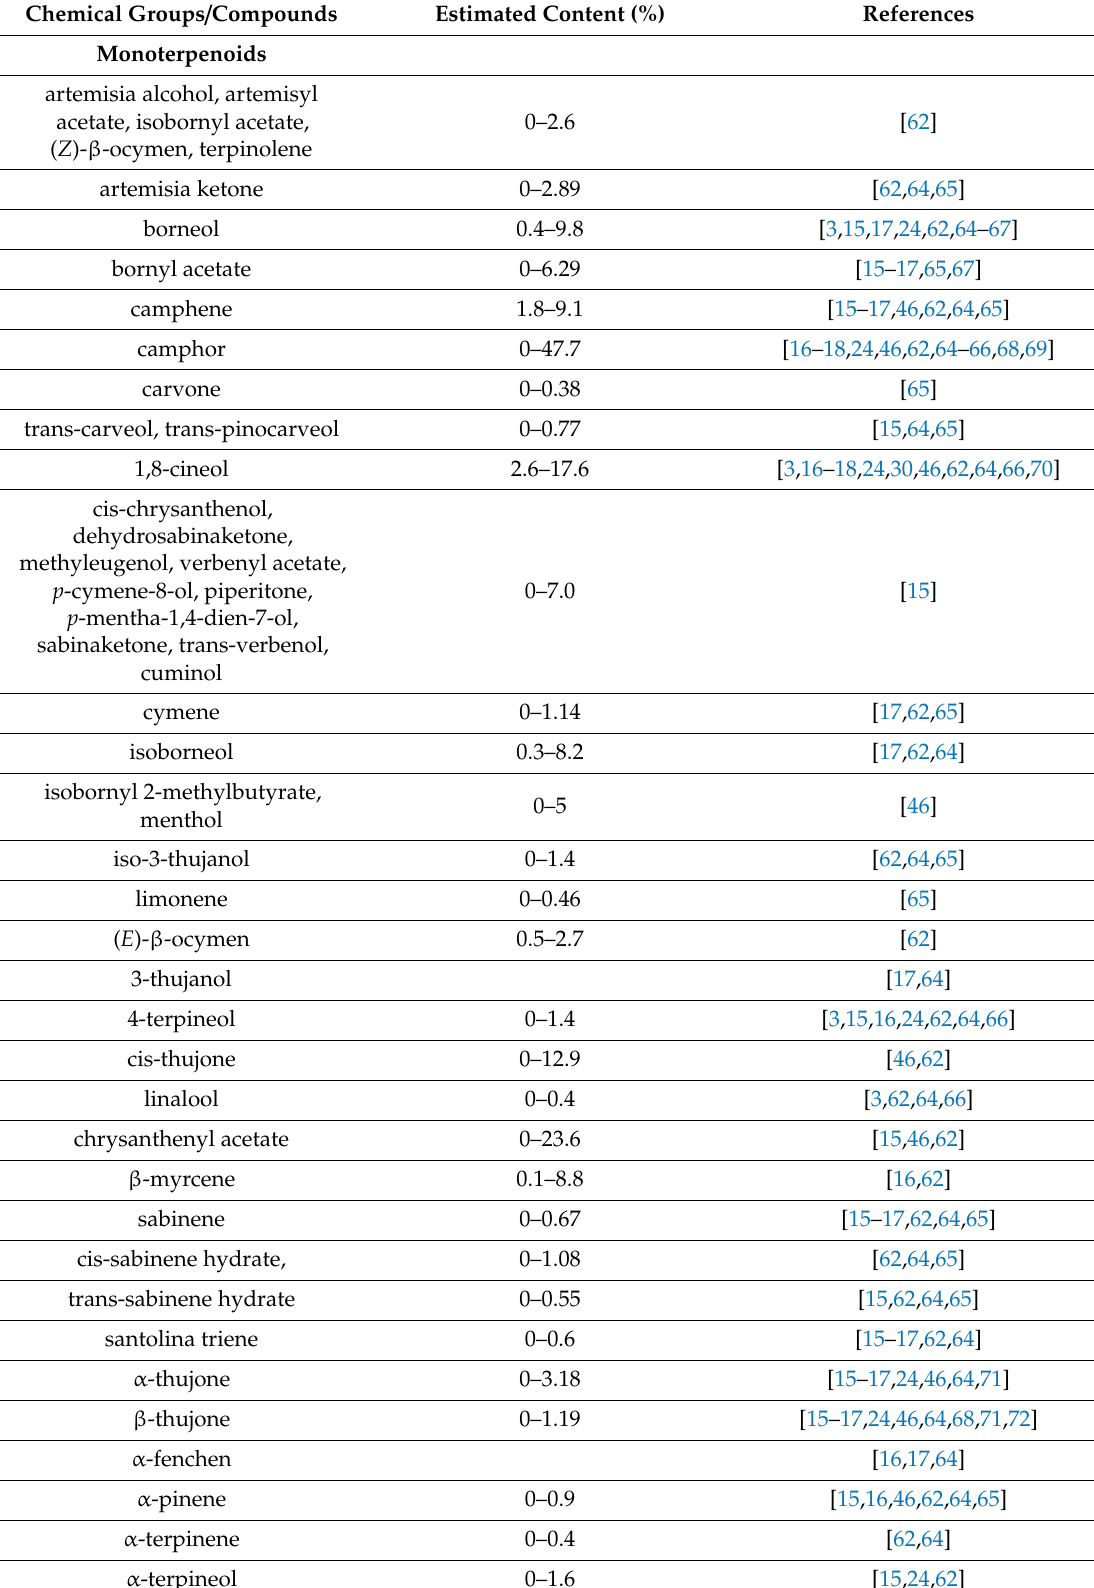
Table 3. The chemical composition of essential oil from A. vulgaris aerial